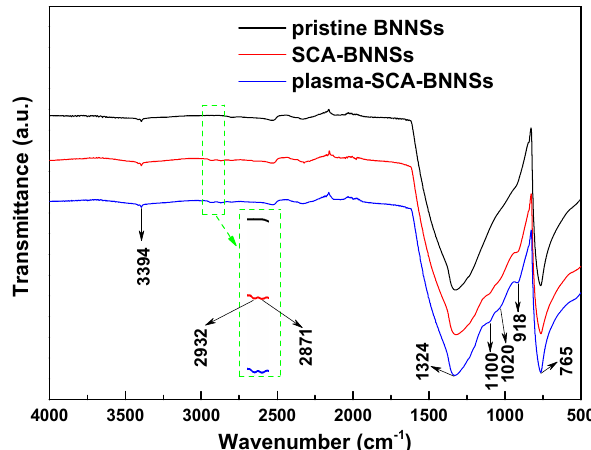
Figure 8. Fourier transform infrared spectroscopy (FTIR) spectra of pristine BNNSs, SCA treated BNNSs (SCA-BNNSs), and plasma and SCA treated BNNSs (plasma-SCA-BNNSs).